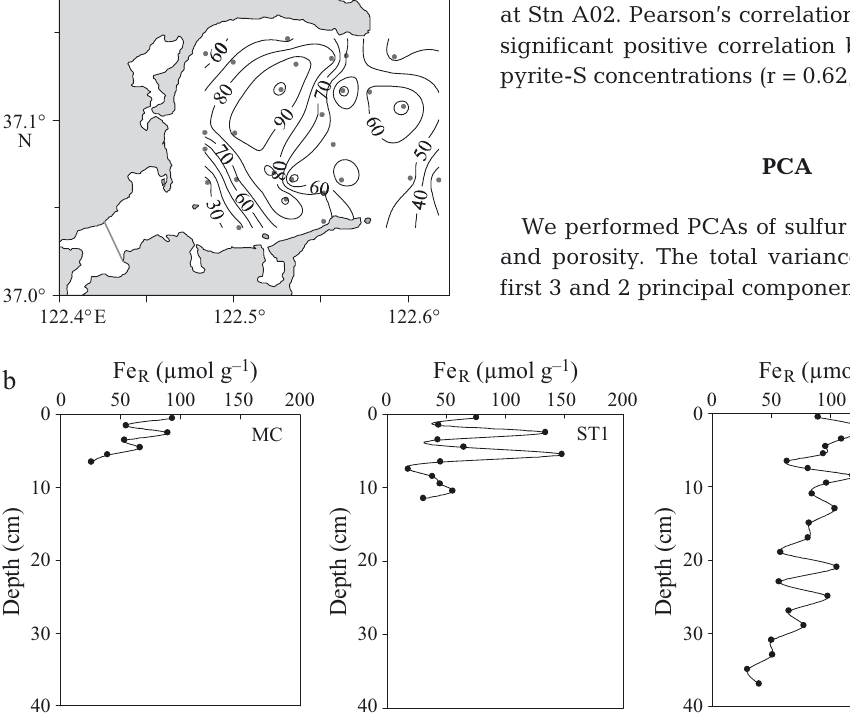
Fig. 5. Distribution of reactive iron (Fe R ; µmol g −1 ) in (a) surface and (b) core sediments of Sanggou Bay and the Yellow Sea (see Fig. 1 for station